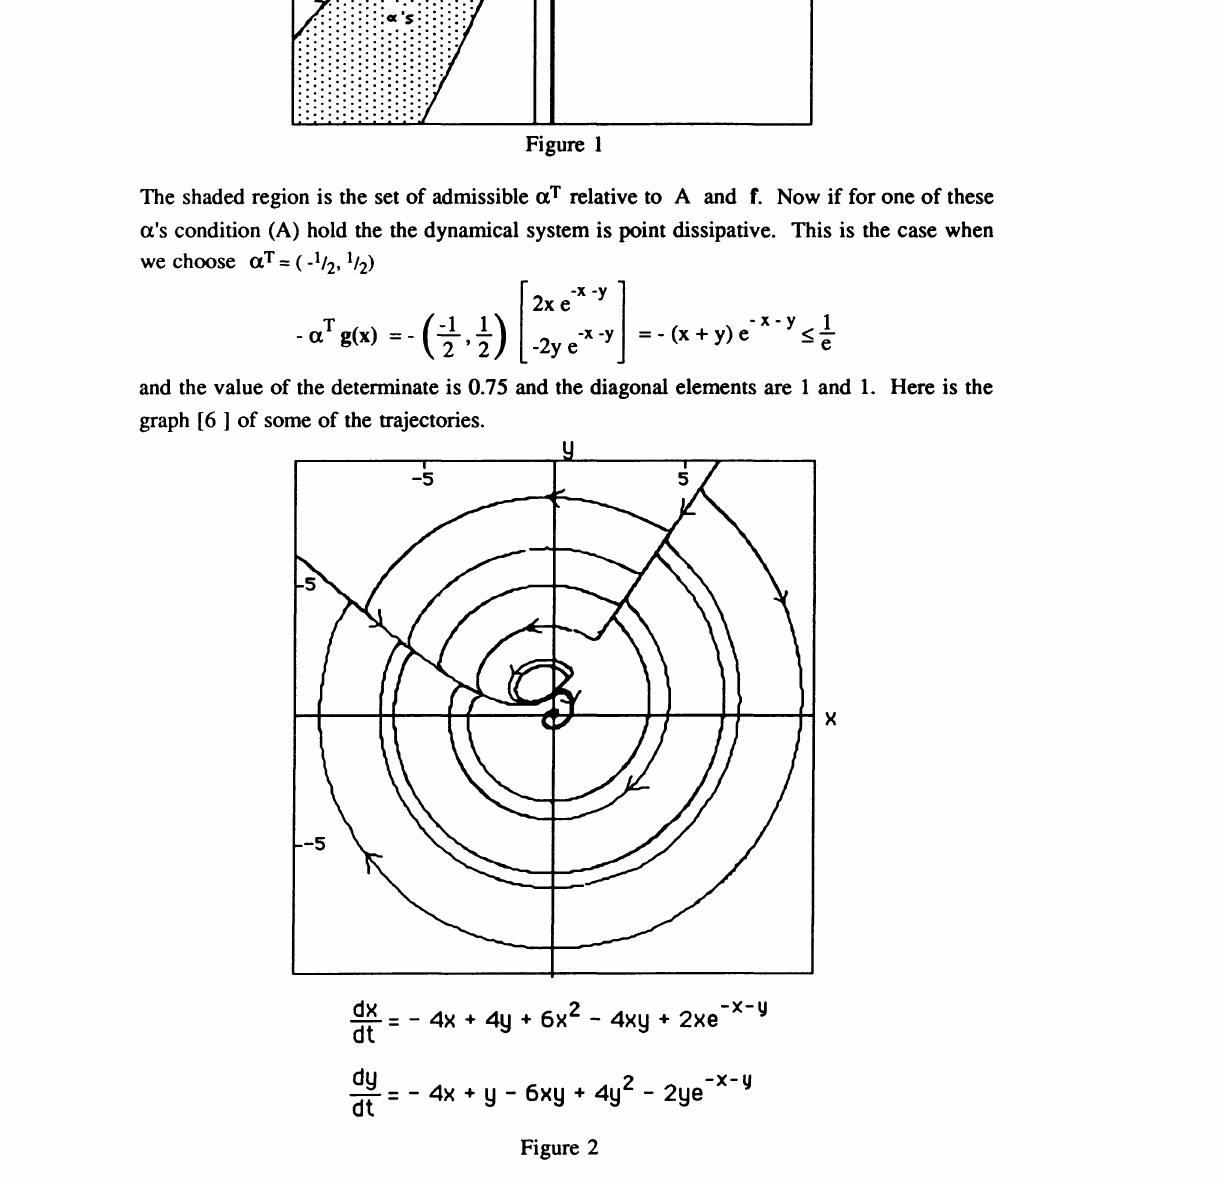
Figure The shaded region is the set of admissible 0t T relative to A and L Now if for one of these t’s condition (A) hold the the dynamical system is point dissipative. This is the case when we choose o T (-1/2, 1/2)